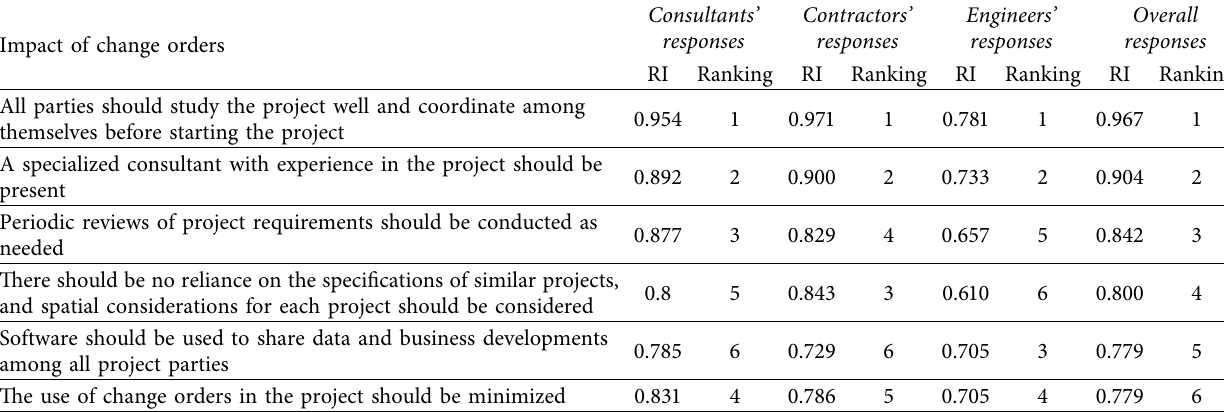
Table 8: )e most important factors that mitigate the impacts of change orders on projects.